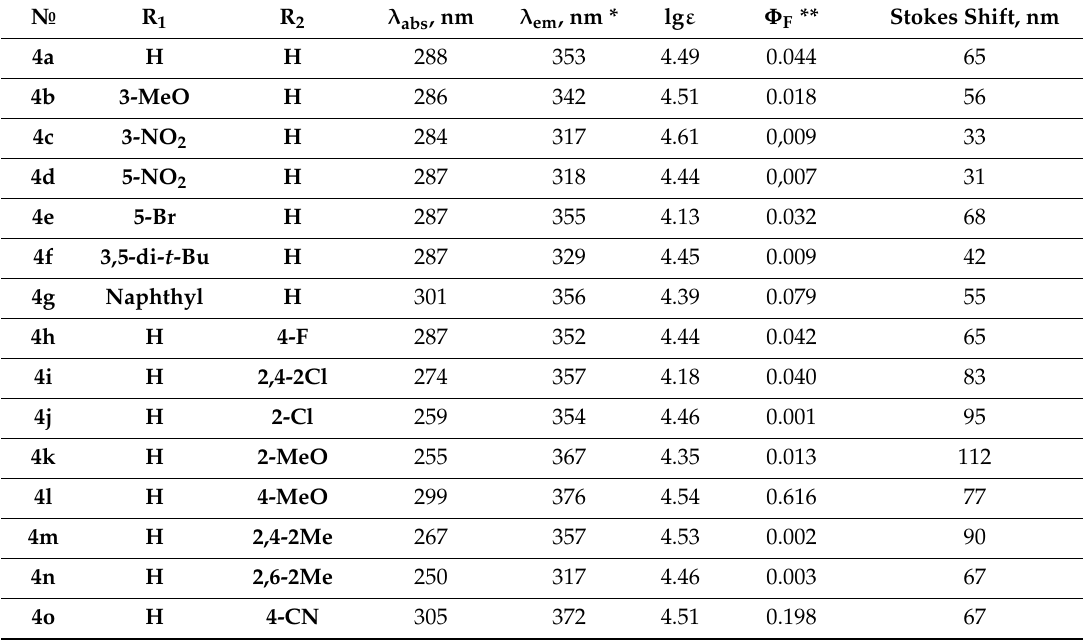
Table 2. Photophysical data of compounds 4a–4o in solution (CH 2 Cl 2 ).